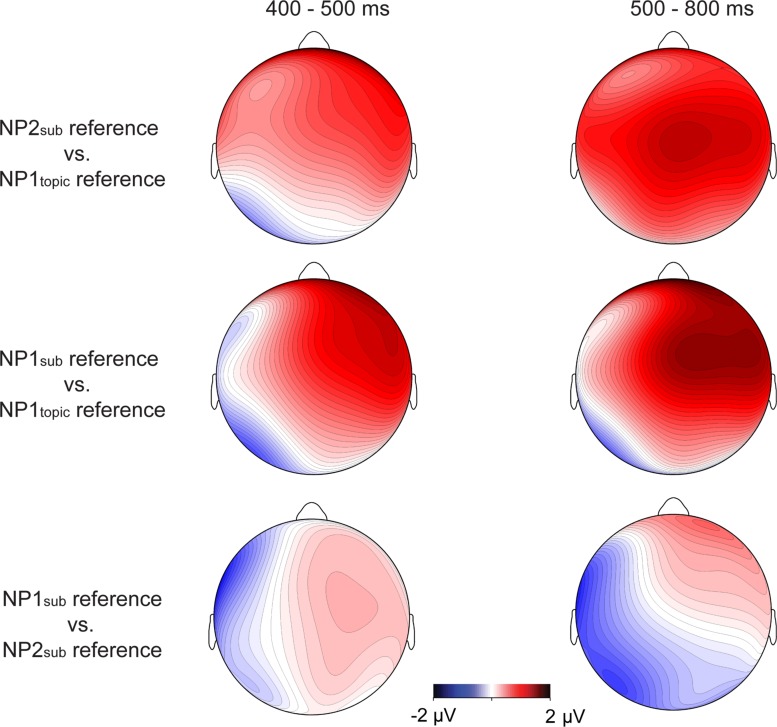
Topographic maps for difference waves on the pronoun in Experiment 1 between the NP2sub reference and the NP1topic reference, and between the NP1sub reference and the NP1topic reference, and between the NP1sub reference and the NP2sub reference in 400–500 ms window (left column) and 500–800 ms window (right column), respectively.